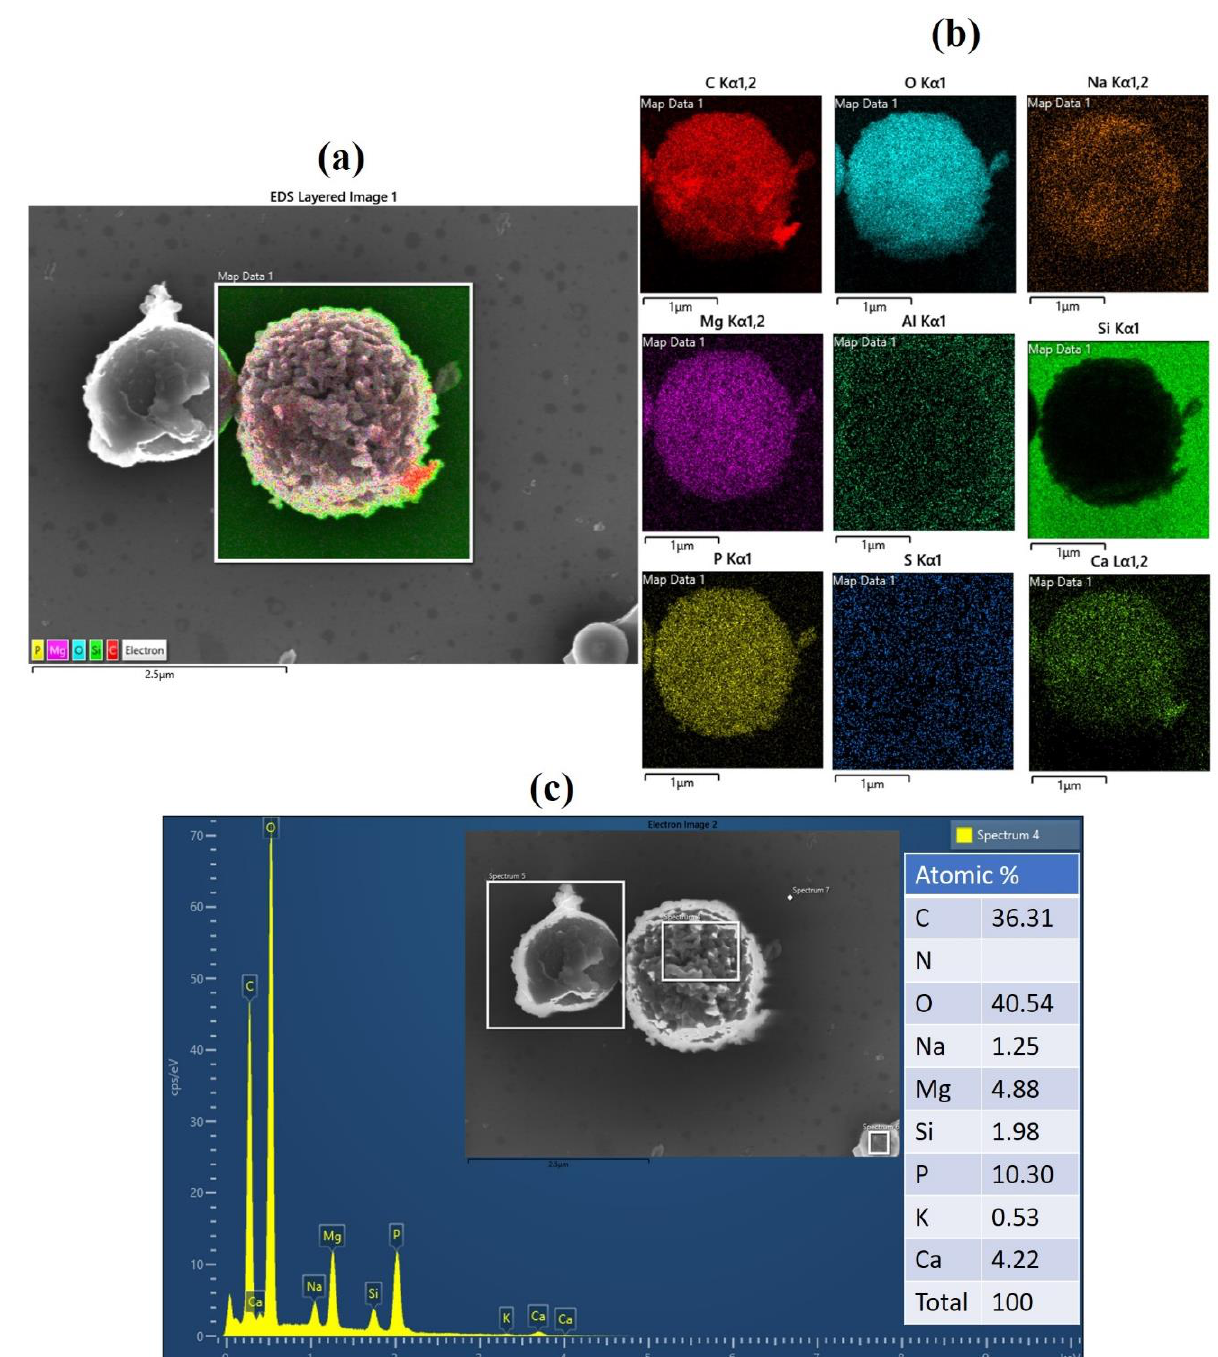
Figure 8. ( a ) FESEM image of B-MP, ( b ) EDX mapping of B-MP, ( c ) EDX spectrum of B-MP (inset: area showing the spectra on which spectrum 4 was performed). (NB: Three different areas were probed and the average composition (in at.%) was as follows: C = 35.0 ± 2.3, O = 39.6 ± 1.9, Na = 1.5 ± 0.8, Mg = 5.2 ± 0.3, Si = 2.7 ± 1.3, P = 11.0 ± 0.6, K= 0.6 ± 0.1, and Ca = 4.5 ±